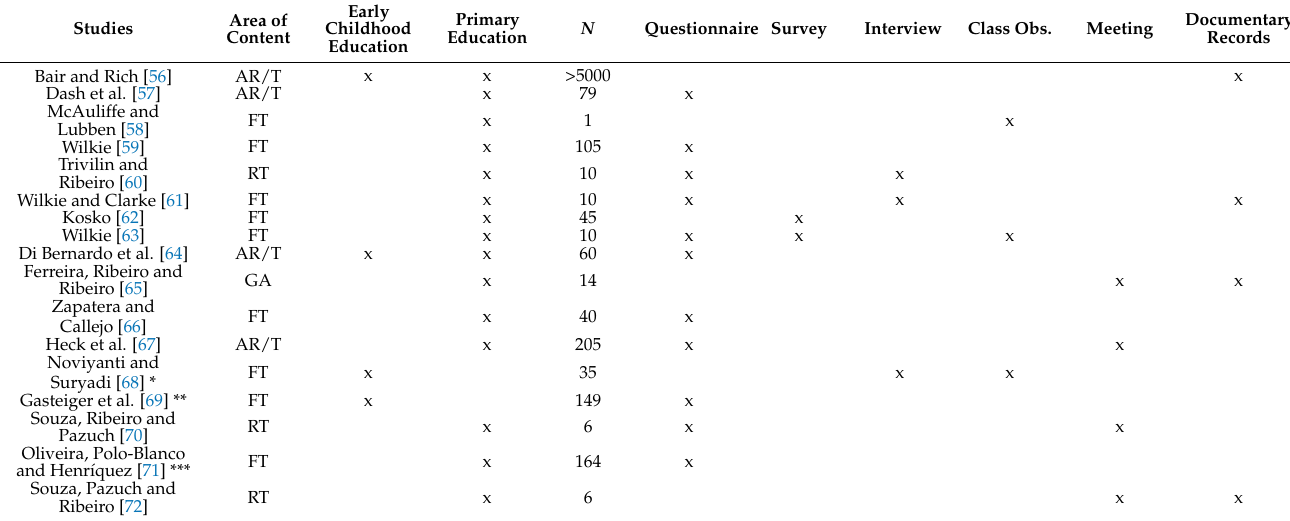
Table 3. Areas of mathematical content addressed in the studies and research methods used to investigate mathematical knowledge for teaching early